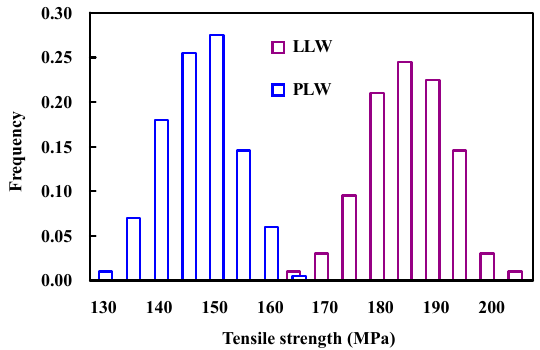
Figure 4. Strength distribution histogram of composites.